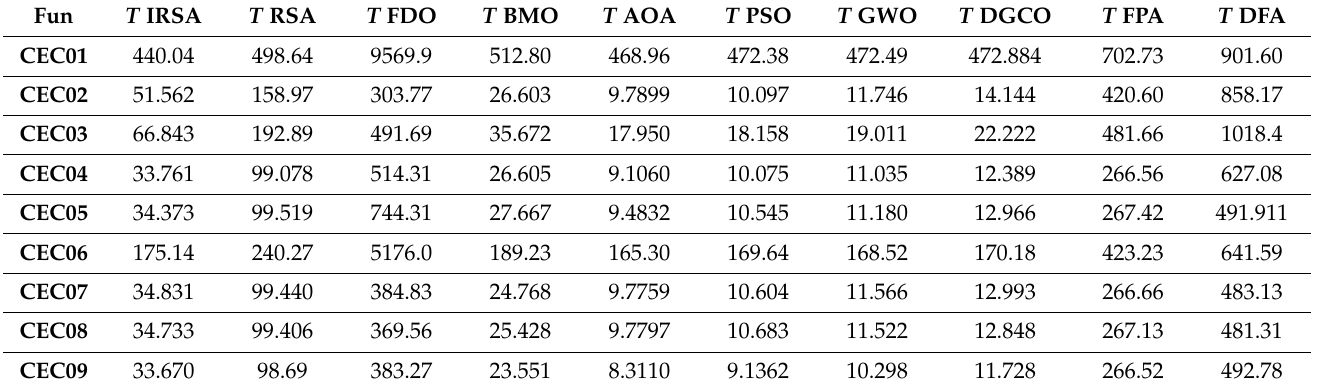
Table 4. (cid:101) T ( sec ) calculation for various metaheuristic algorithms.